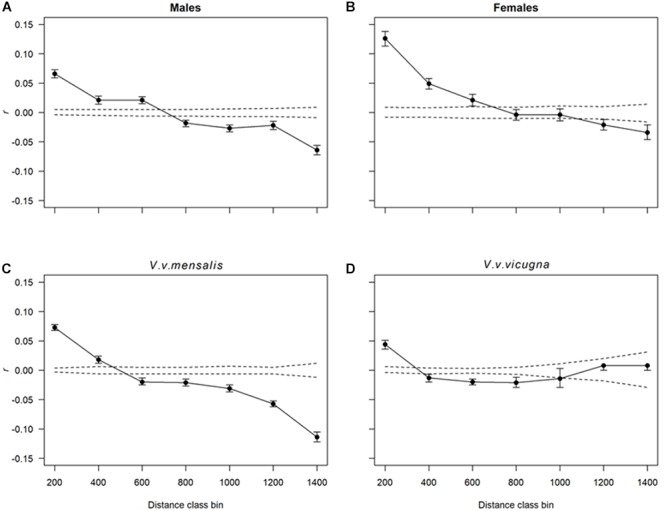
Correlograms showing the combined spatial correlation r across transects as a function of distance. Dotted lines correspond to the 95% CI about the null hypothesis of a random distribution of genetic variation over space (i.e., no effect of geographic distance on r). Each r value has 95% confidence error bars shown. Distance class bins are shown in kilometers. Each plot shows the autocorrelation for distance class sizes of 200 km estimated for (A) males, (B) females, (C) all northern vicuñas (V. v. mensalis) and (D) southern vicuñas (V. v. vicugna).